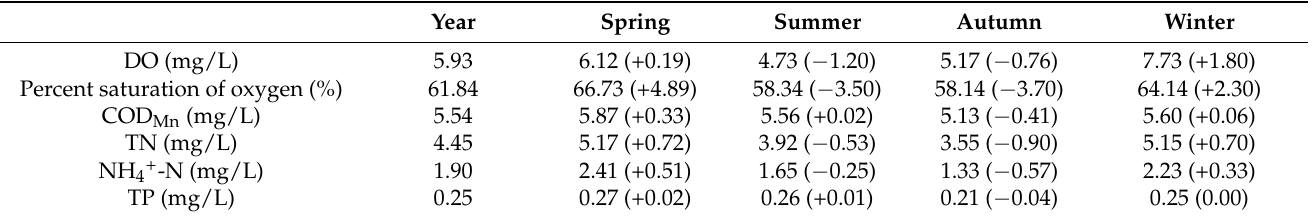
Table 3. Mean concentrations and percent values in different seasons.